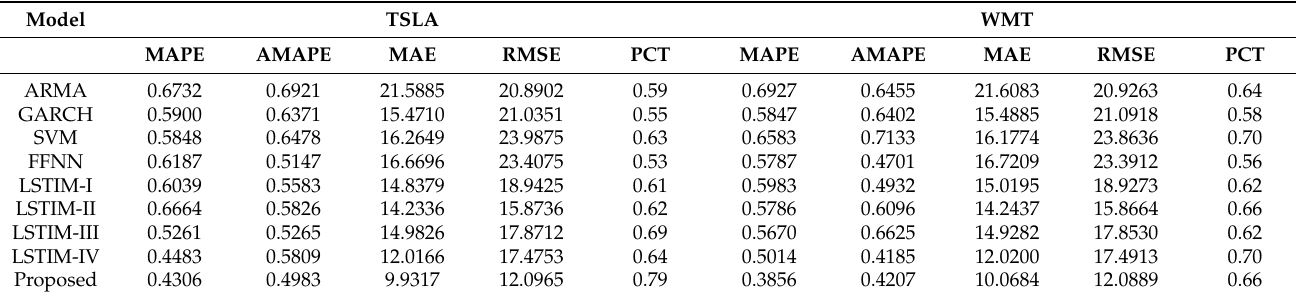
Table 17. Prediction performance for 300 days: TSLA and